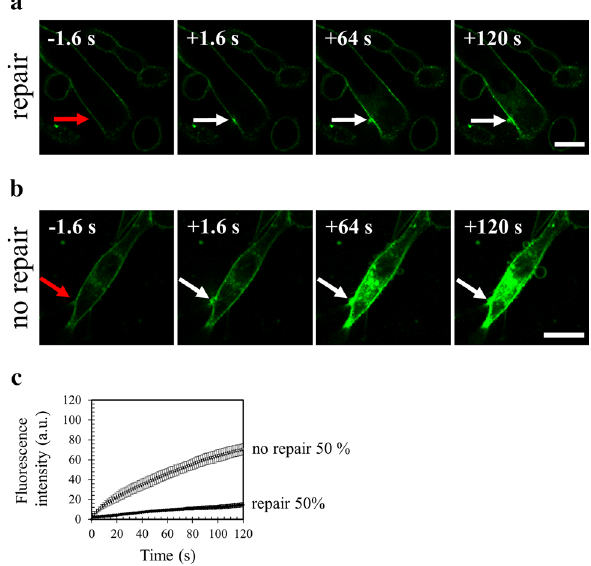
Figure 4. Responses of MDA-MB-231 cells to a membrane damage by laser ablation. Sequence of representative images showing the response of a MDA-MB-231 cell resealing ( a ) or not ( b ) a membrane damage performed by 110-mW infrared laser irradiation, in the presence of FM1-43 (green). Before irradiation, cells were washed 3 times in cold D-PBS containing 2 mM Ca 2+ and then maintained in this medium. In all figures, the area of membrane irradiation is marked with a red arrow before irradiation and a white arrow after irradiation. Image frames 1 and 2 were recorded 1.6 s before and 1.6 s after irradiation, respectively; Image frames 3–4 were recorded 64 s and 120 s after irradiation, respectively, as indicated. Scale bar: 20 μm. ( c ) Kinetic data represent the FM1 − 43 fluorescence intensity integrated over whole cell sections, averaged for about